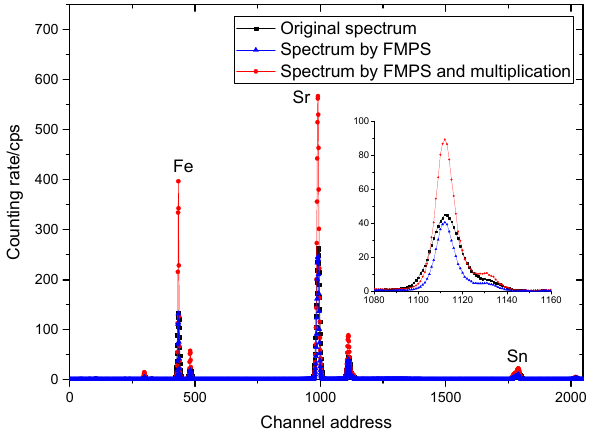
Figure 8. Comparison of the spectra obtained by different algorithms.